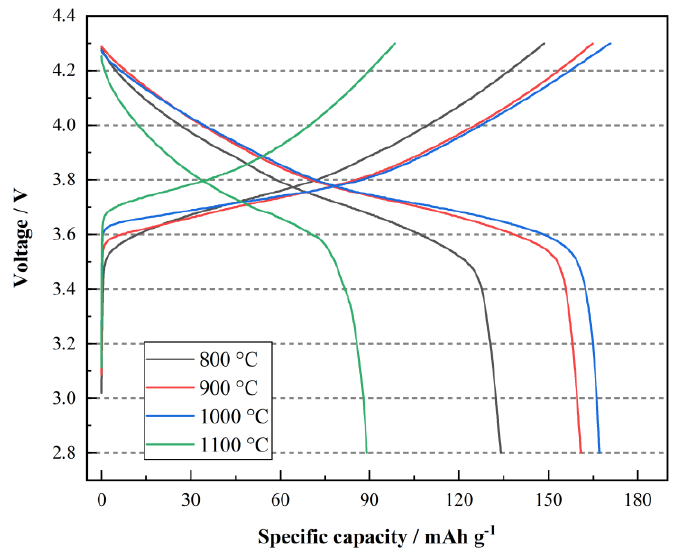
Figure 5. Initial charge/discharge curves of the half cells with LiNi 0.5 Co 0.2 Mn 0.3 O 2 synthesized at (a) 800 °C, (b)900 °C, (c)1000 °C and (d)1100 °C.